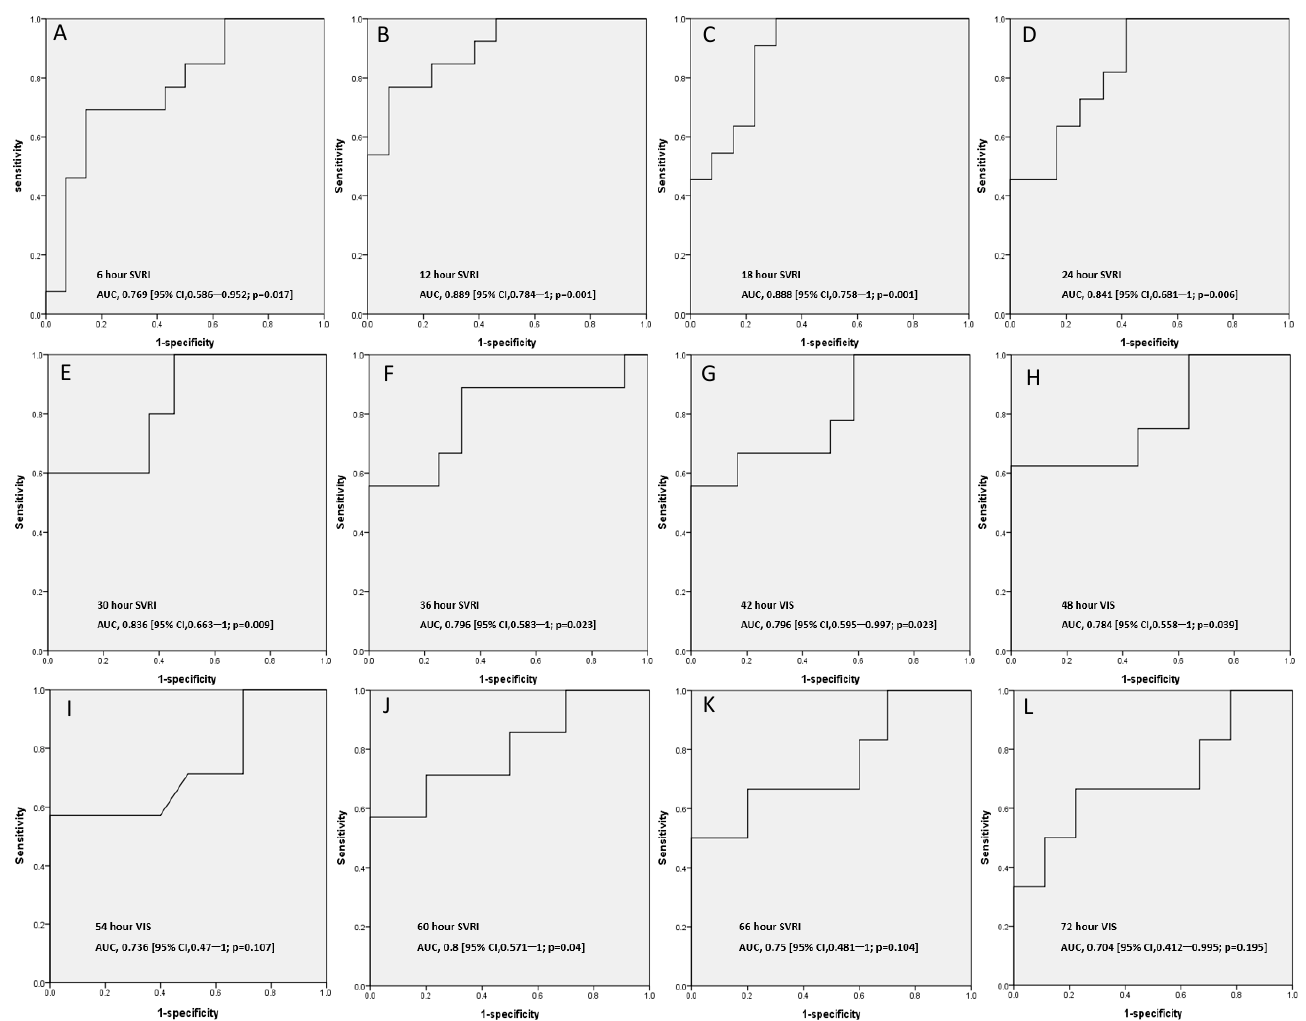
Figure 6. Predicting 28-day mortality at 6 h intervals using the best AUC. ( A – L ) 6–72 h. Table 4. Best cutoff values of hemodynamic parameters at 6 h intervals within 72 h after the PiCCO setup.